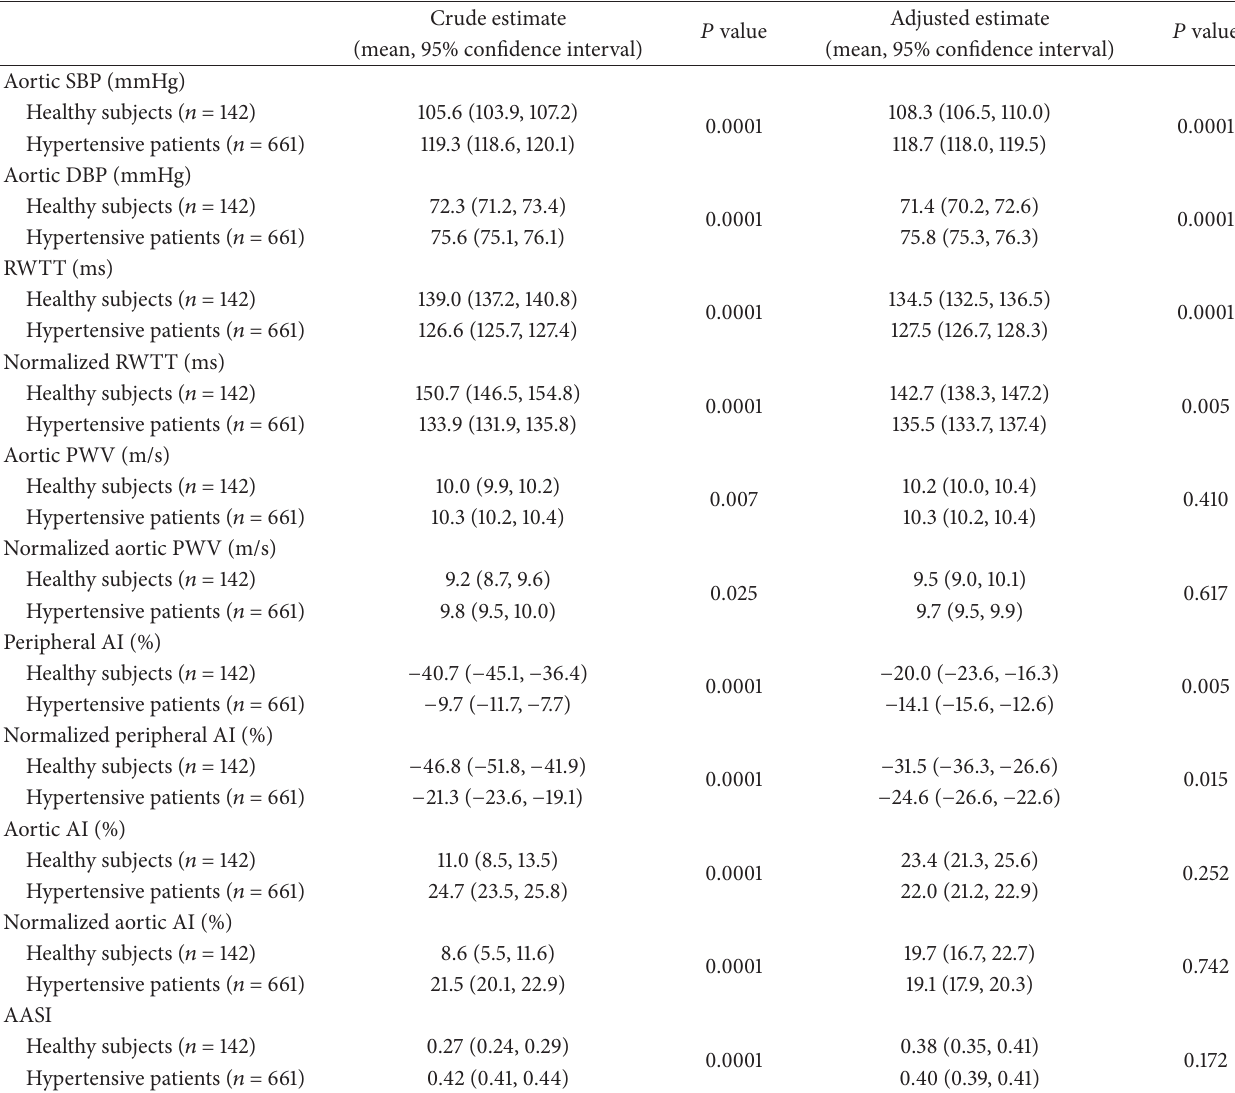
Table 2: Unadjusted (crude) and adjusted (by age, gender, body mass index, antihypertensive drug treatment, and 24-hour SBP and DBP) estimates for 24-hour BP and arterial stiffness parameters in healthy subjects and hypertensive